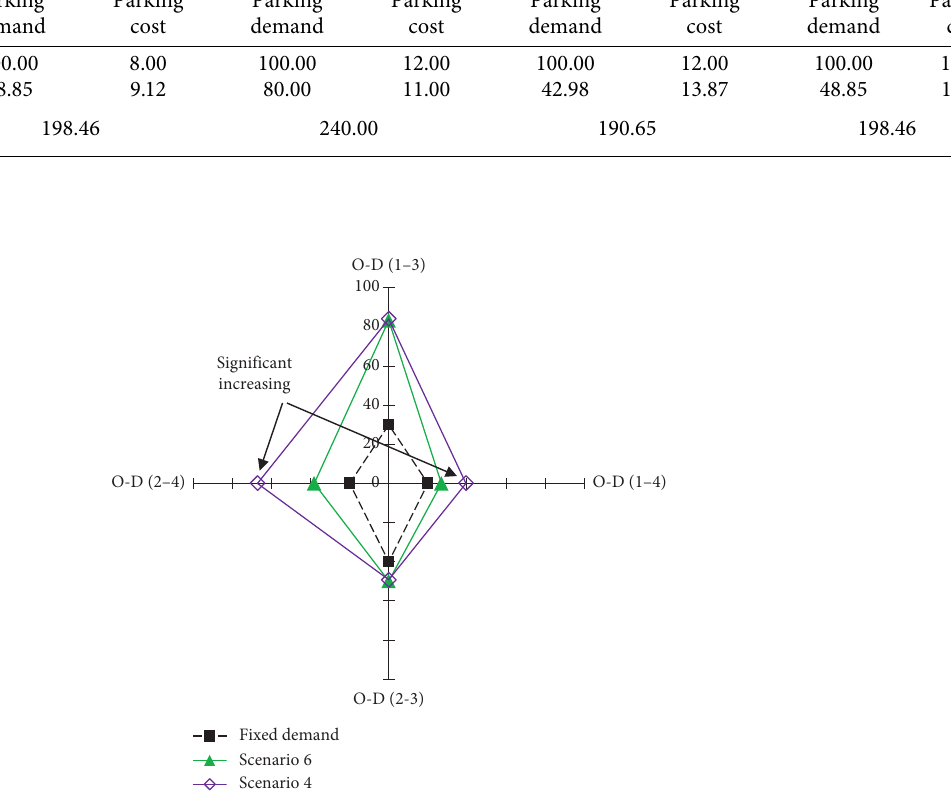
Figure 3: O-D demand pattern of maximum flow for Scenario 4 and Scenario 6.